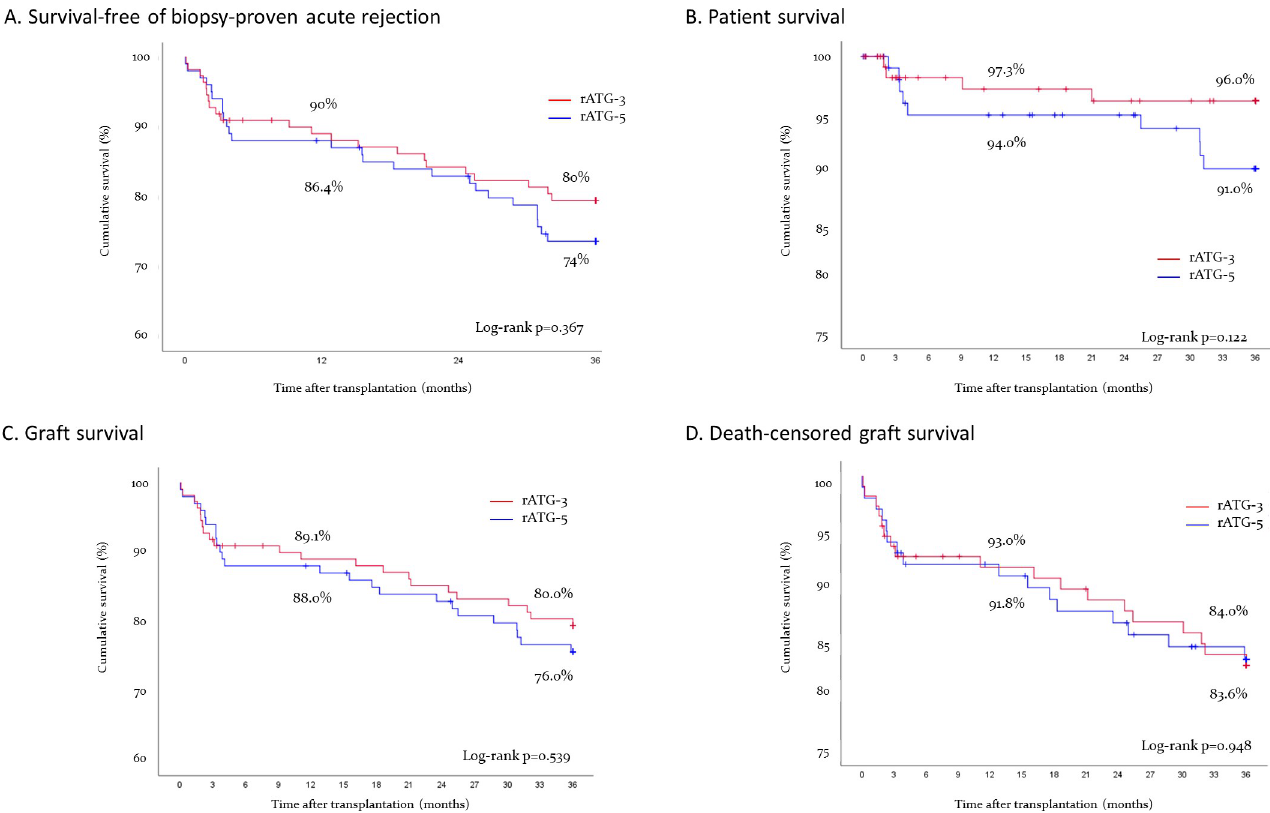
Fig 2. Cumulative survival-free of first biopsy proven acute rejection (A), patient survival (B), graft survival (C) and death-censored graft survival (D), in patients undergoing retransplantation receiving 5 or 3 mg/kg rATG induction therapy.